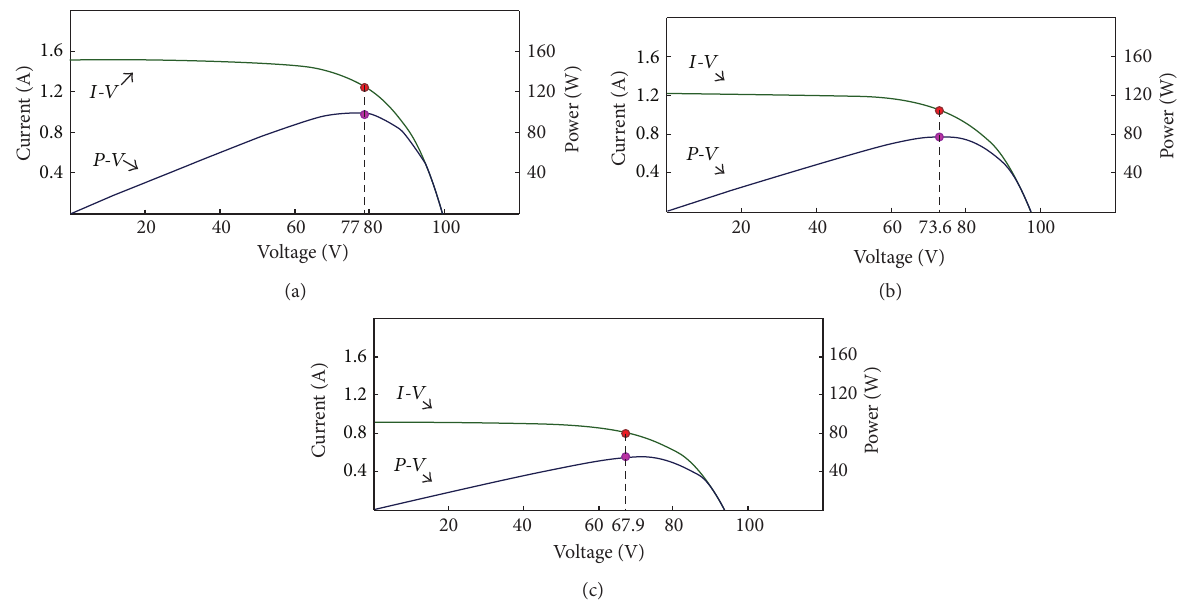
Figure 11: 𝑃 - 𝑉 and 𝐼 - 𝑉 curves based on the proposed HMPPT method under illumination intensity: (a) 1000 W/cm 2 ; (b) 800W/cm 2 ; (c) 600 W/ cm 2